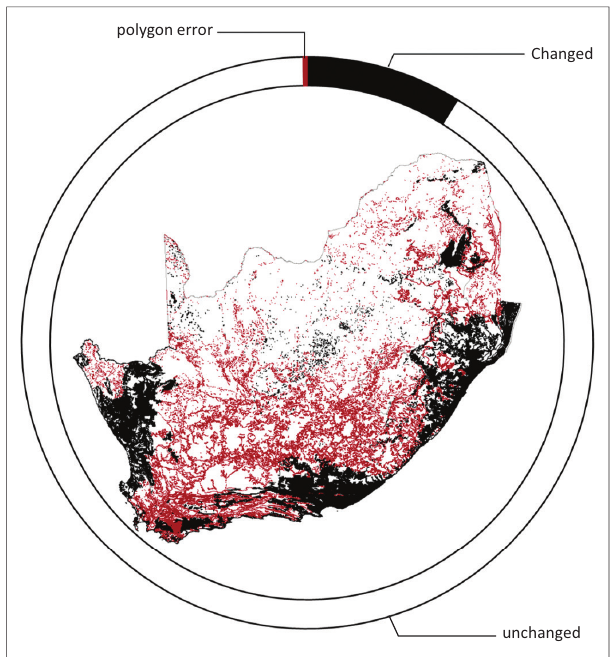
FIGURE 2: Overview of the changes to the area ( % ) of the National Vegetation Map from 2006 to 2018 showing the area that is unchanged (clear), edited for change (black) and corrected for node creep error (red and in bold to increase visibility of narrow polygons).